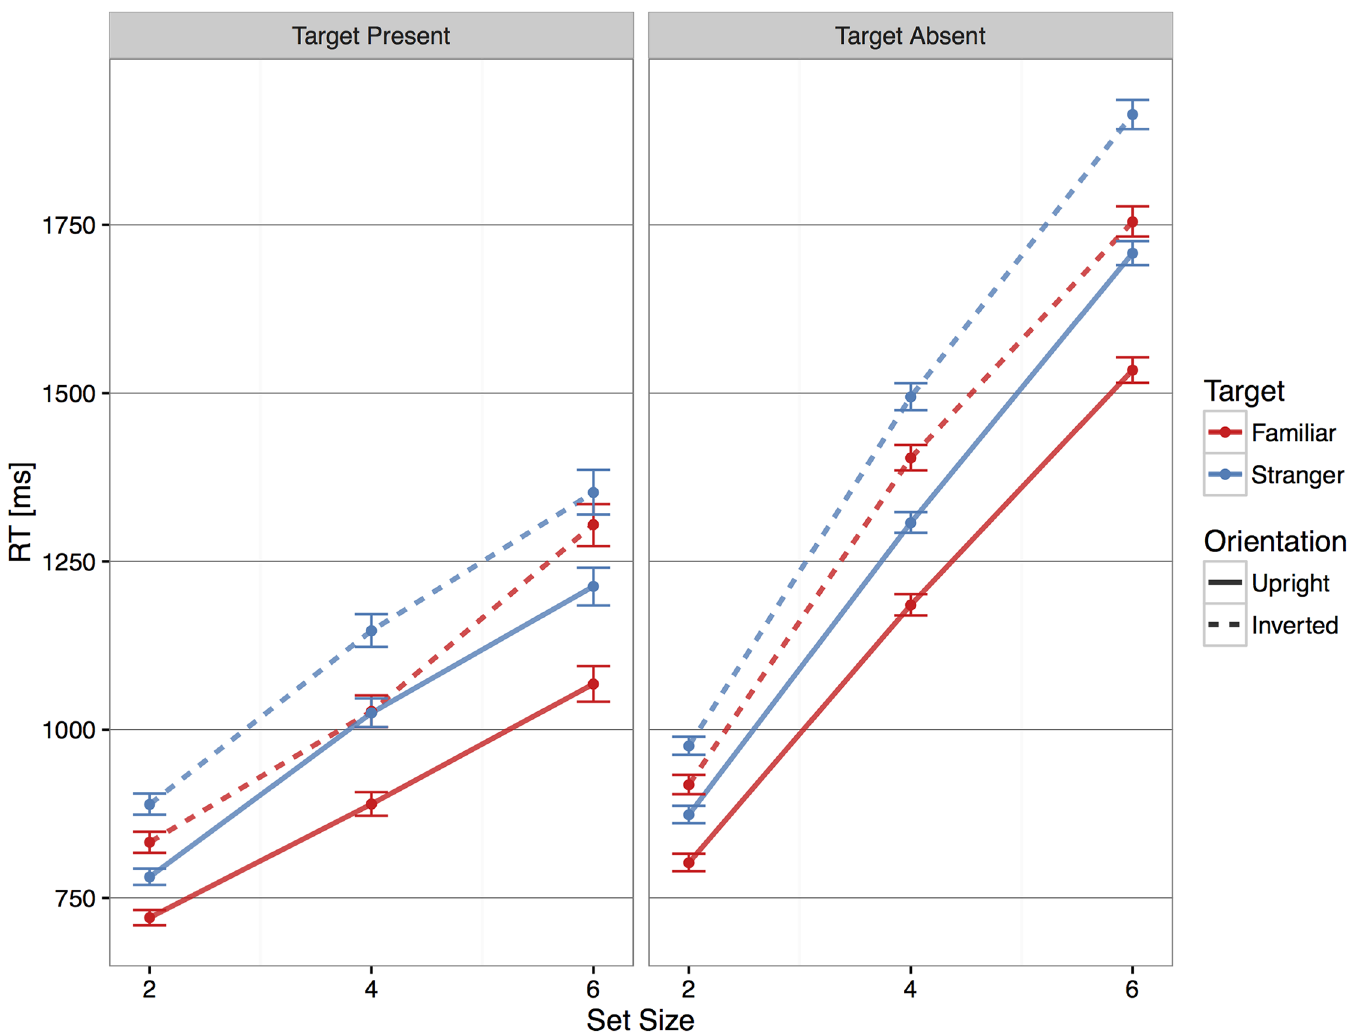
Fig 3. Average reaction times according to presenceof the target. Subjects were always faster at determining the presenceor absenceof a familiar target face comparedto a strangertarget face. Solid lines show upright condition,dashedlines show invertedcondition.Red: familiar targets; Blue: stranger targets. Error bars show 95% bootstrapped